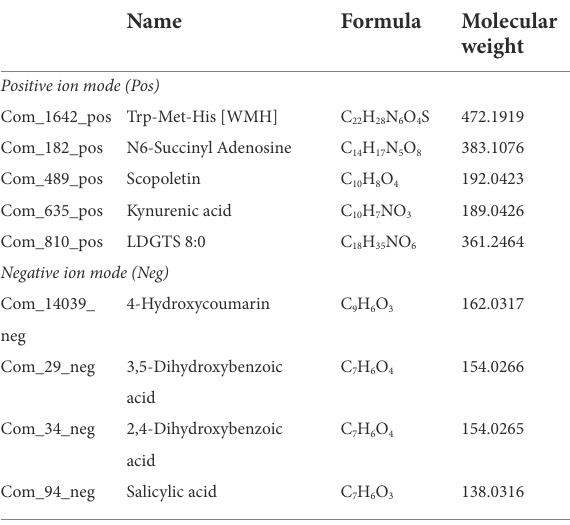
TABLE 1 Candidate components in MBE for promoting the growth of Sanghuangprous vaninii